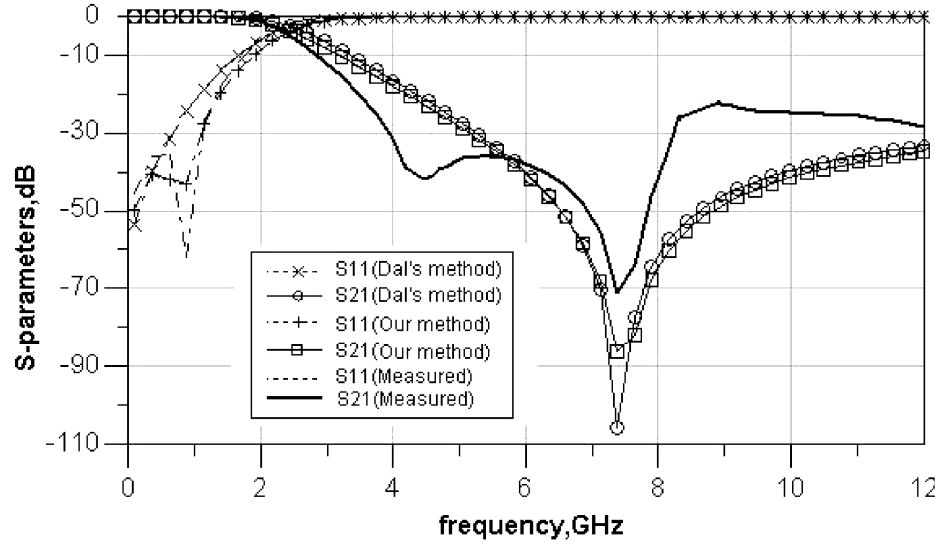
FIGURE 4 Characteristics of the designed LPF with